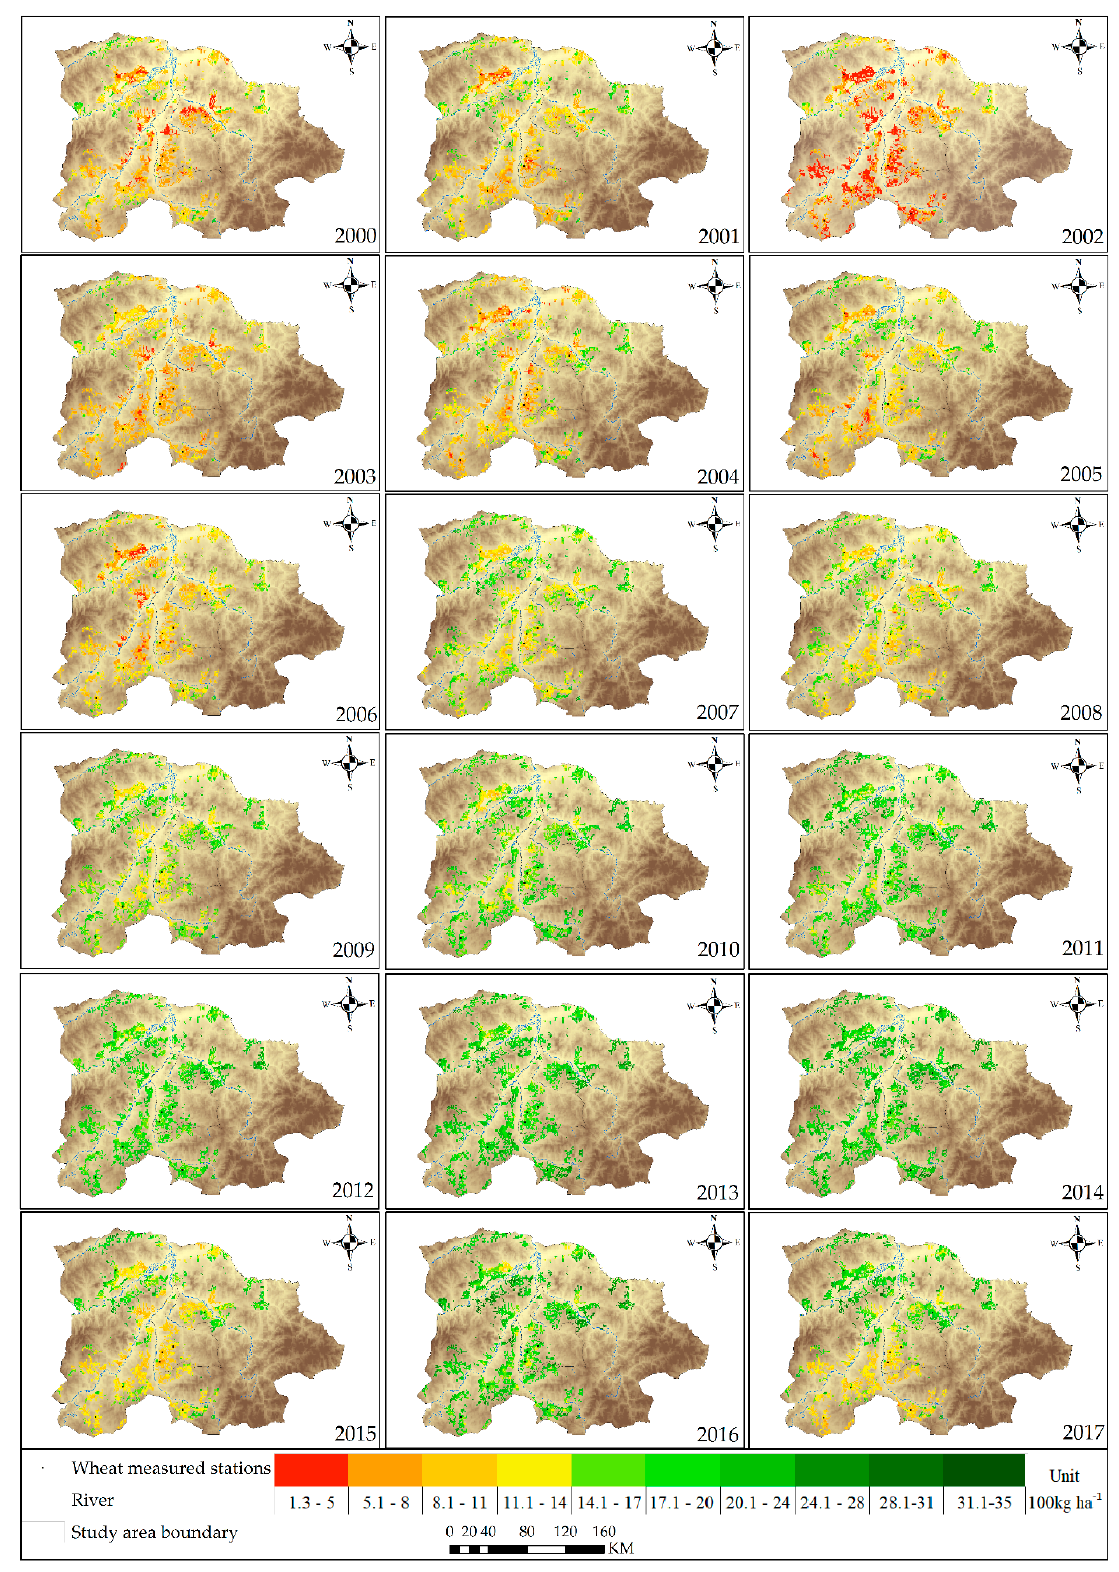
Figure 9. Estimated temporal and spatial spring wheat yield map at the regional level.